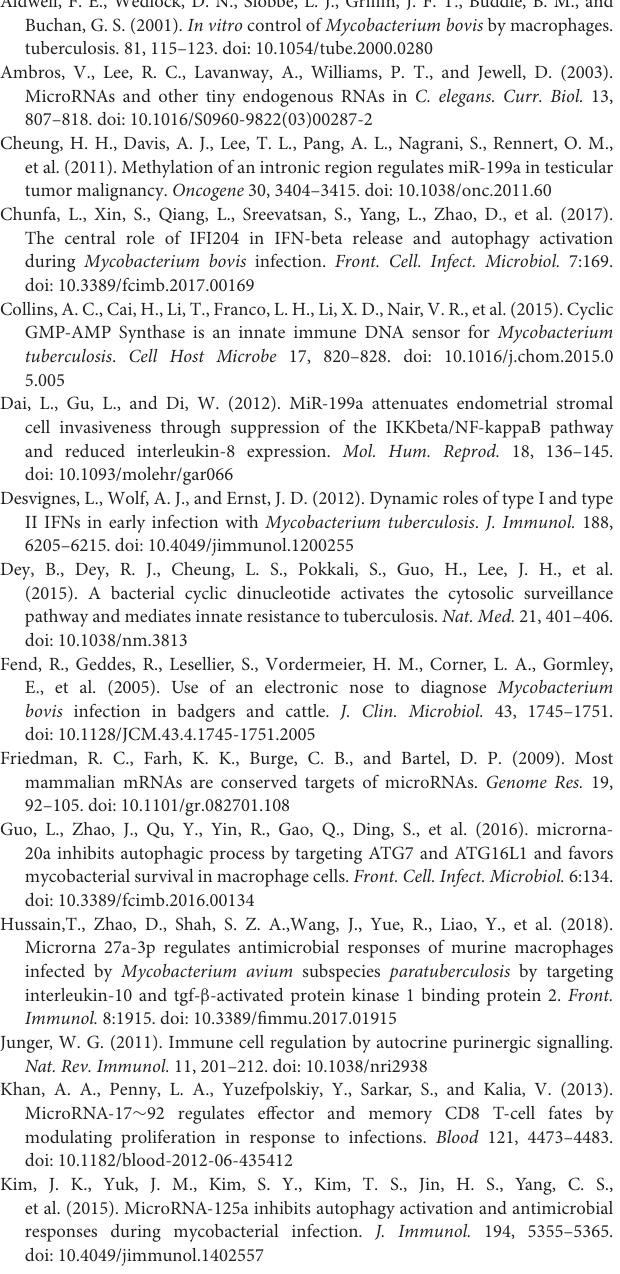
Supplementary Figure S2 | Full blot images of western blot results with expected weights along with a protein ladder. (A) a full blot image of TBK1 protein already shown in Figure 2F (B) a full blot image of p-IRF3 protein already shown in Figure 5I (C) a full blot image of p-IRF3 protein already shown in Figure 6A . Supplementary Table S1 | Gene sequences of miR-199a and TBK1 used in cells transfection experiments. Supplementary Table S2 | Predicted targets of miR-199a from target